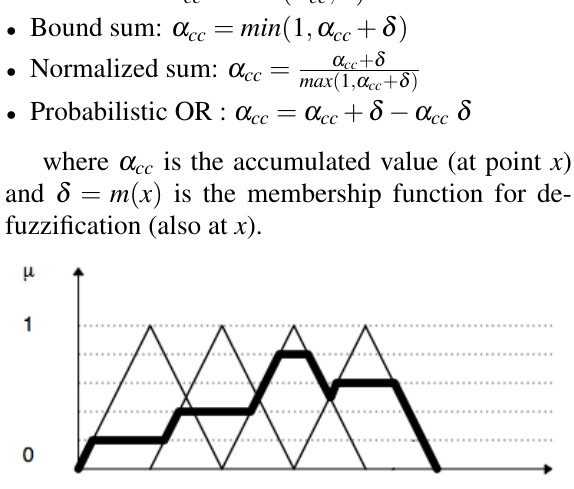
Fig. 4. Accumulation method: Combining consequents from multiple rules using Max accumulation